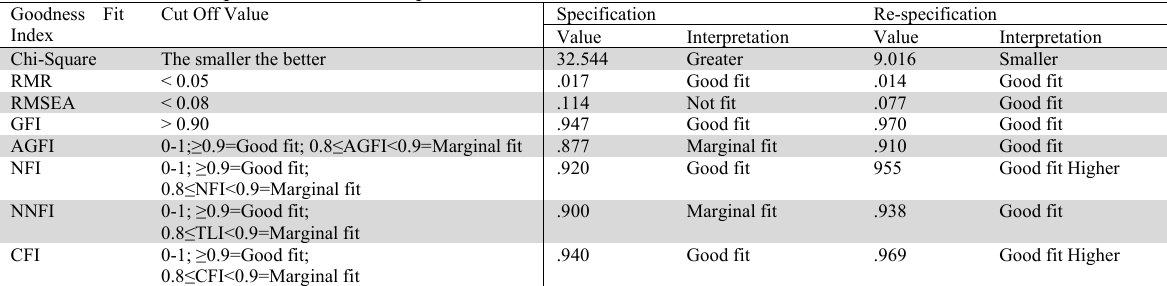
Goodness fit Statistics specification and re-specification of Decision Model of the